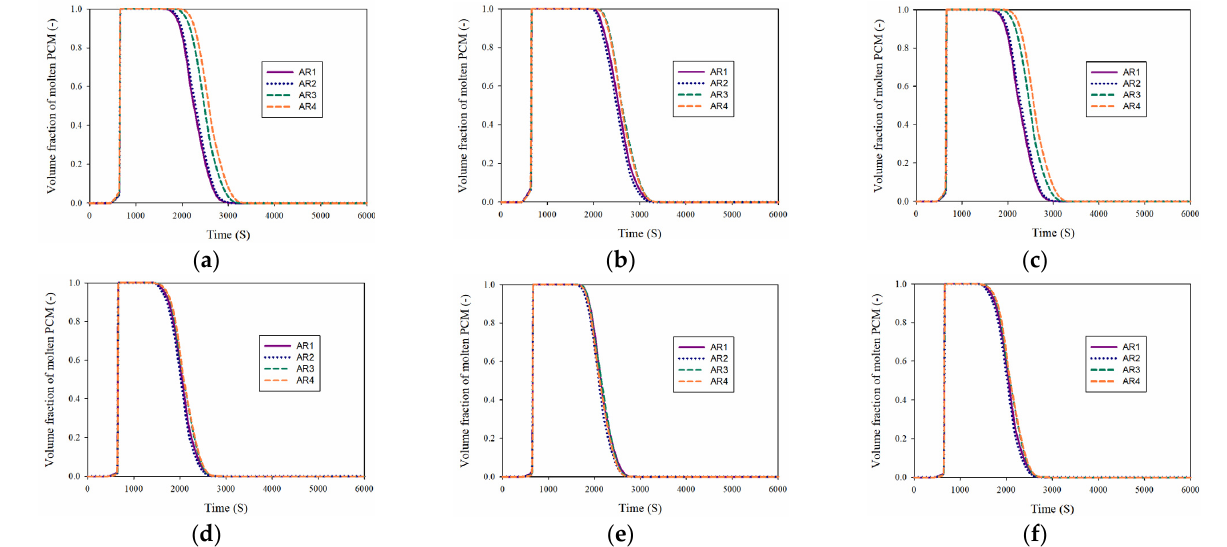
Figure 10. Volume fraction of molten PCM around BTCLs for various values of cavity AR up to 6000 s. ( a ) cell 1 ( b ) cell 2 ( c ) cell 3 ( d ) cell 4 ( e ) cell 5 ( f ) cell Figure 11 demonstrates the volume fraction of molten PCM around the BTPC for different values of cavity AR up to 6000 s. The changes in the amount of molten PCM in the BTPC are completely different. From time 620 s to 680 s, all the PCM is converted from